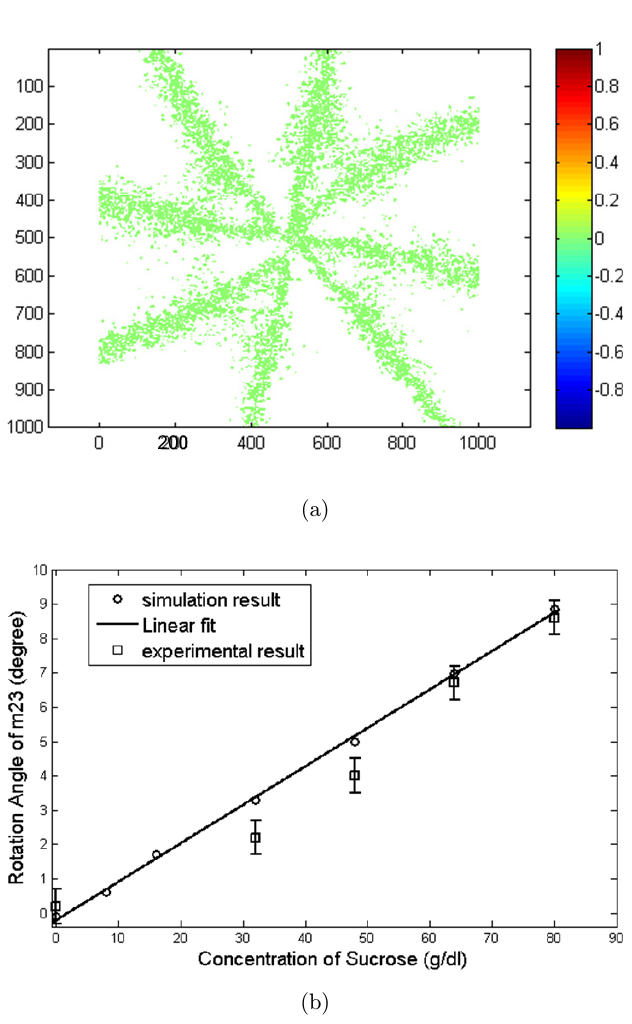
Fig. 6. Backscattering Mueller matrix element m 23 for sphere optical active medium: (a) zero-intensity pro¯le of the m 23 and (b) rotation angle of the m 23 change with the concentration of